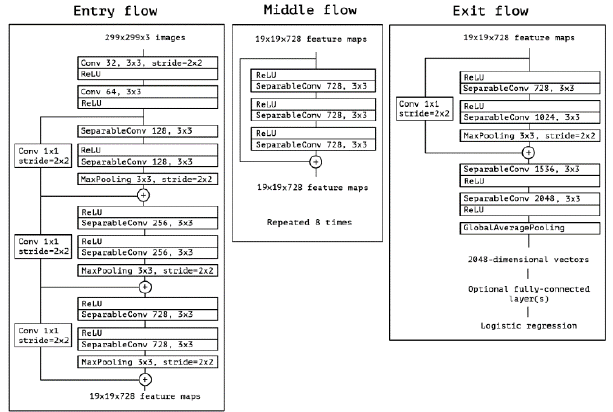
FIGURE IV. XCEPTION ARCHITECTURE.